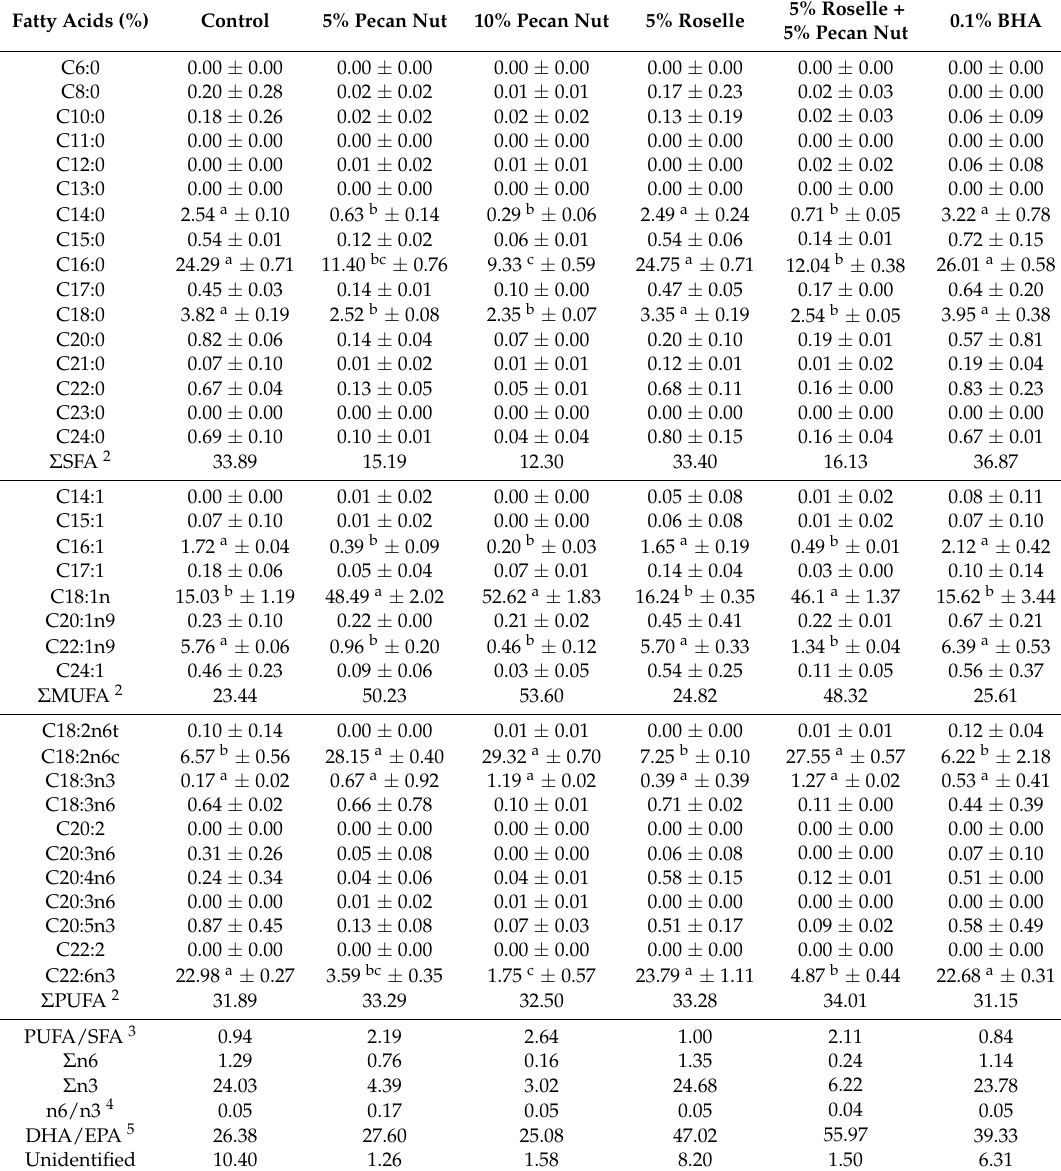
Table 4. Fatty acids profiles of Sardina pilchardus muscle with different treatments